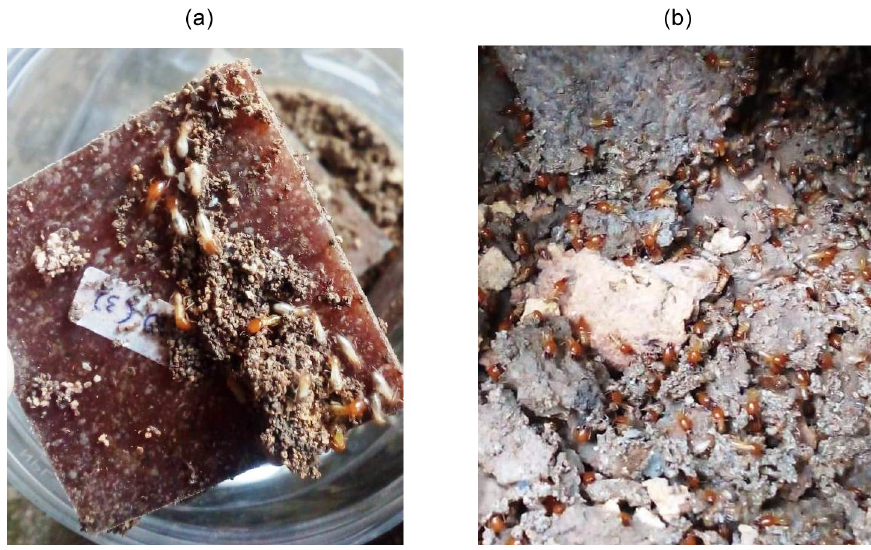
Fig 1. C . curvignathus termites (a) with WPCs as food source (b) in native habitat.